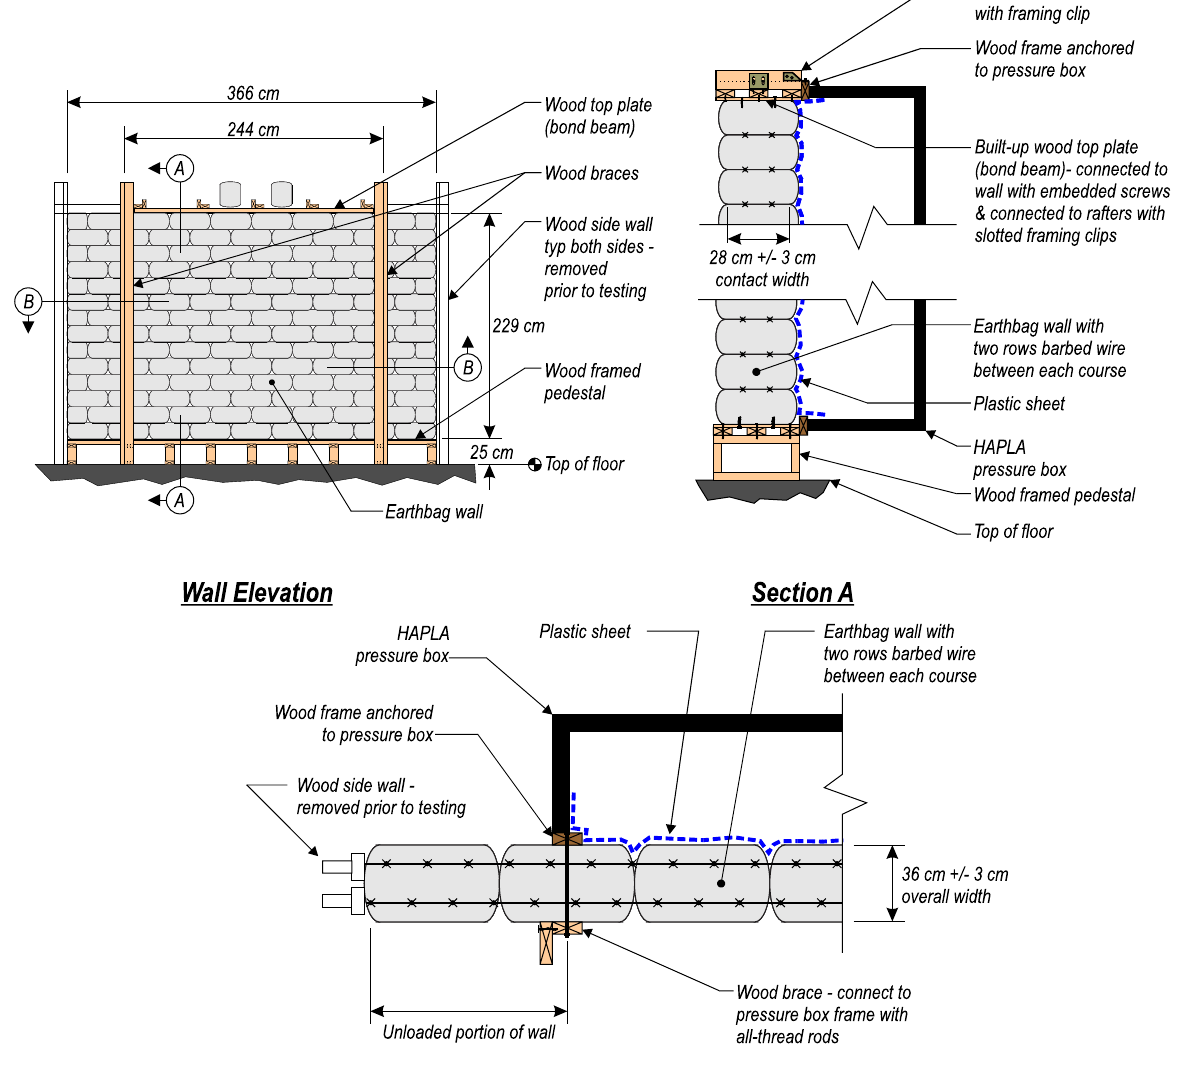
Figure 1. Elevation and details of earthbag test